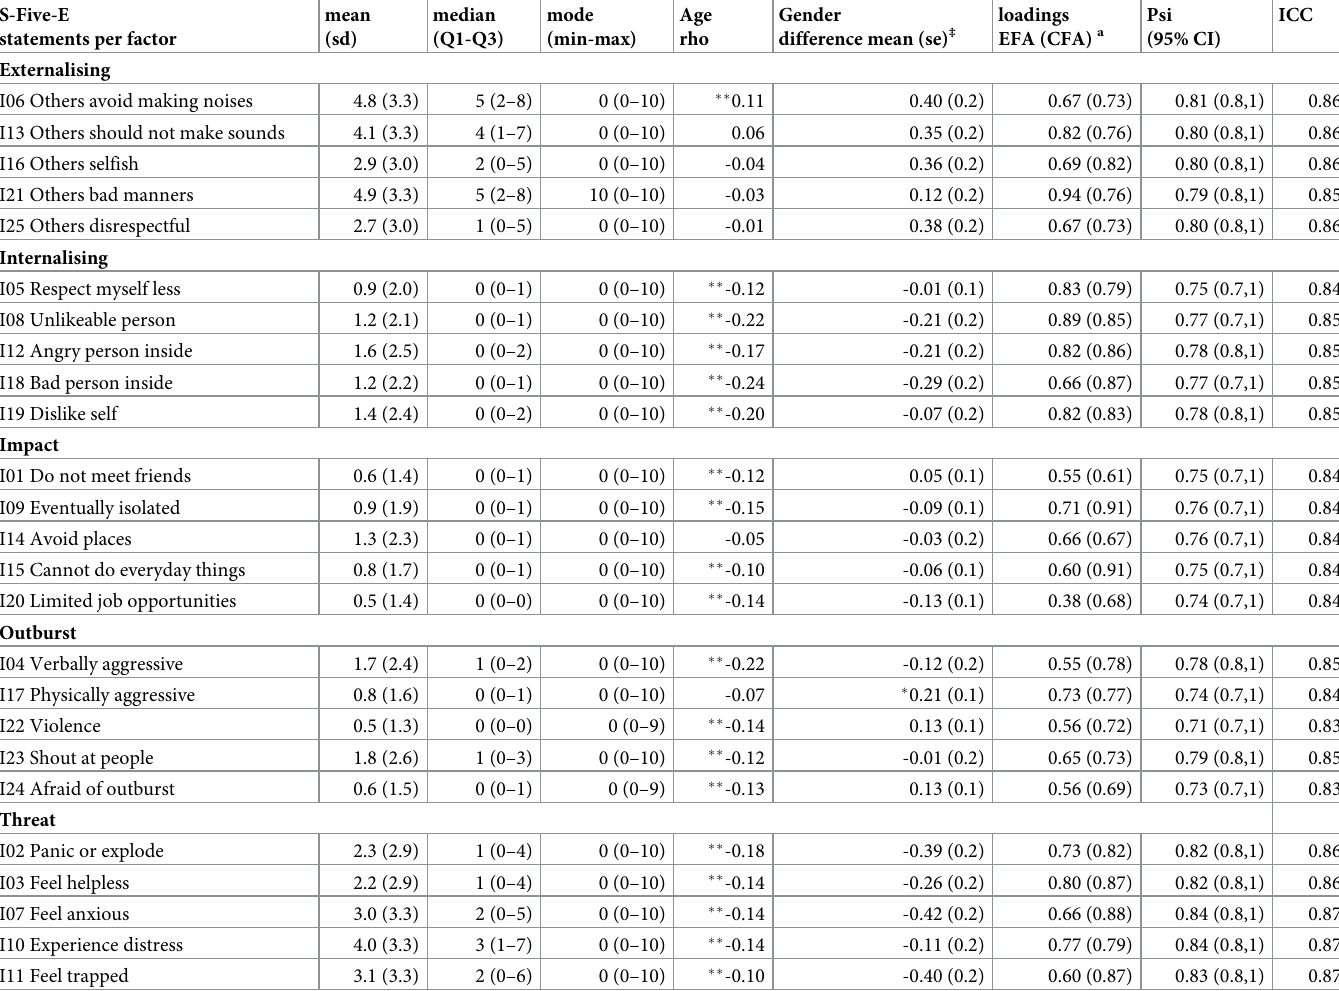
Table 1. Descriptive indices, associations with age and gender, factor analysis loadings, and reliability indices of the 25 S-Five items (N =